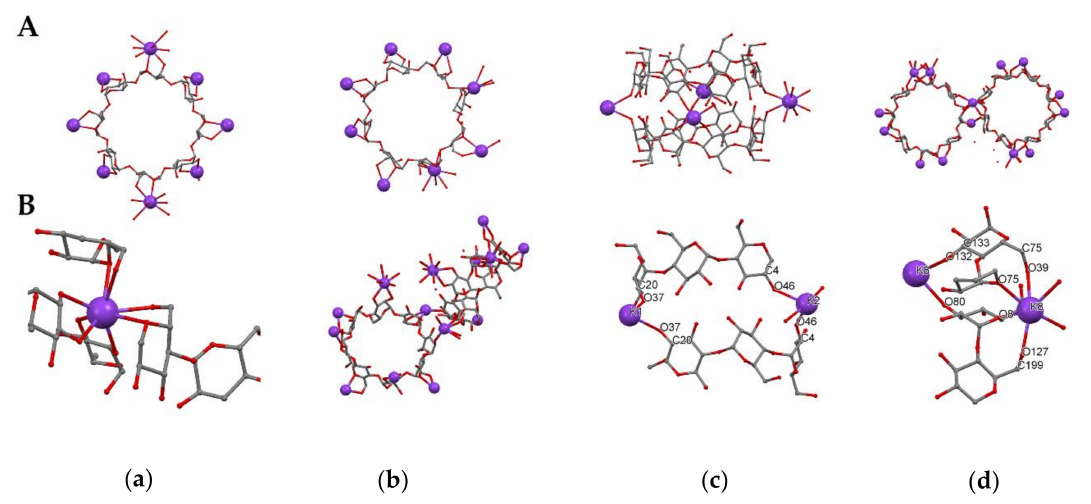
Figure 2. A—Arrangement of γ -CD ring in ( a ) α -, ( b ) β -, ( c ) ε -, and ( d ) δ -phase. B—Coordination of K +